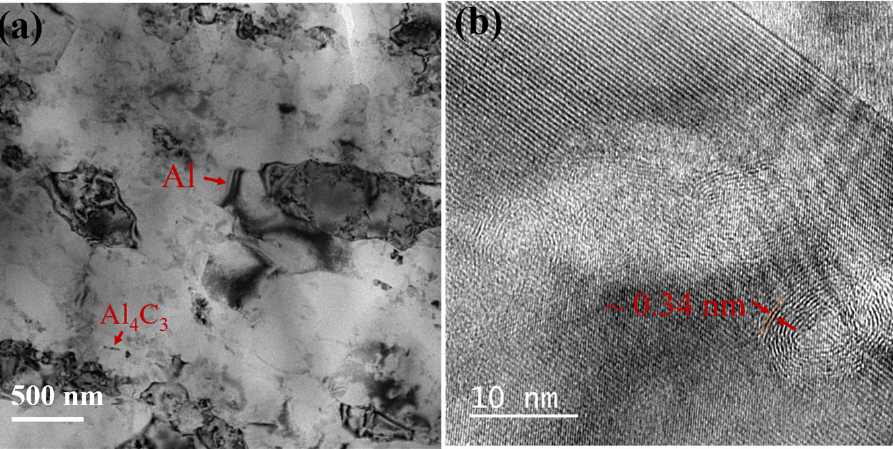
Figure 1. ( a , b ) show microstructure of CNTs/Al − Mg − Si alloy composite before shot peening. Multiple shot peening was conducted via an air blast machine at normal temperature.